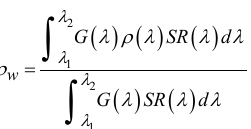
coated PERT solar cells. 2